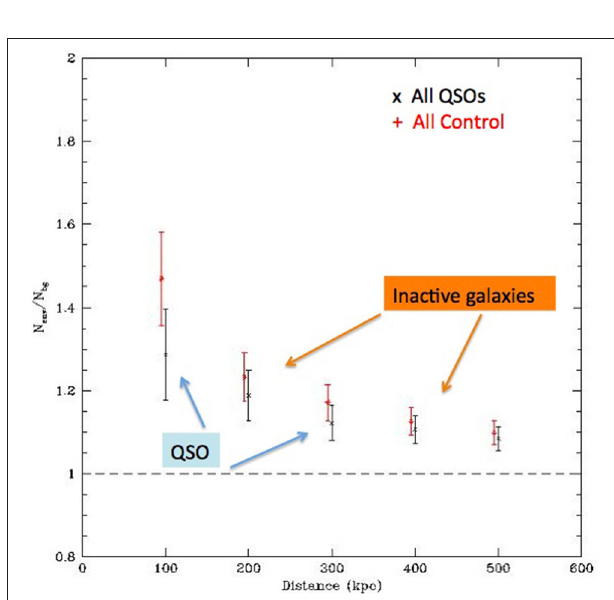
FIGURE 3 | Galaxy over-density in the environment of quasar compared with that of inactive galaxies at same redshift and luminosity.